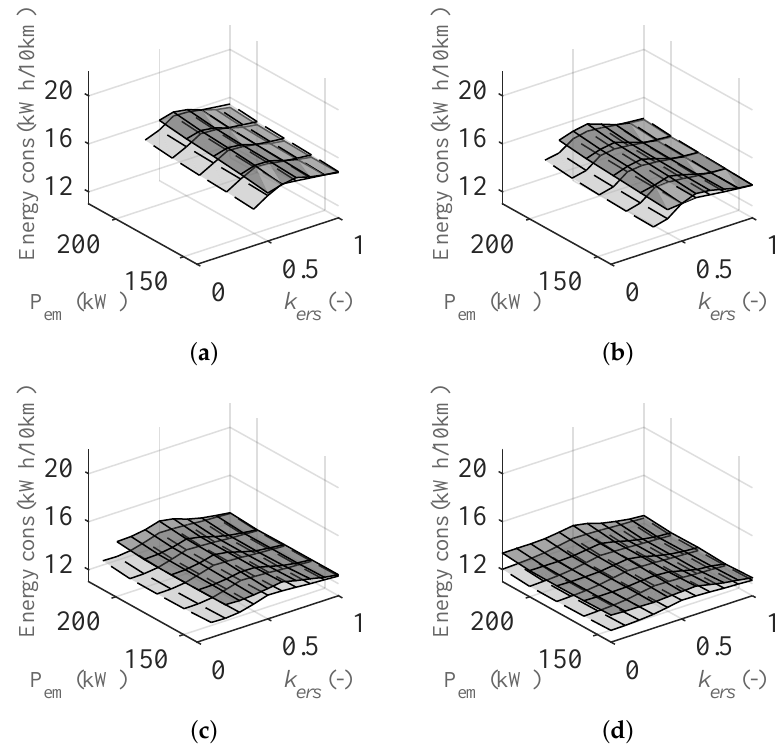
Figure 14. Energy consumption (kWh/10 km) of a city bus on “City bus route 85”, utilising the maximum regeneration (MxRE) control strategy as a function of the rated power of each traction machine, P em , and the ratio of ERS-coverage, k ers , with d ers = 1 km. Each subfigure represents a specific amount of battery capacity; ( a ) The area with dashed lines and a light grey surface is the LSERS, and the dark grey area is the FIERS